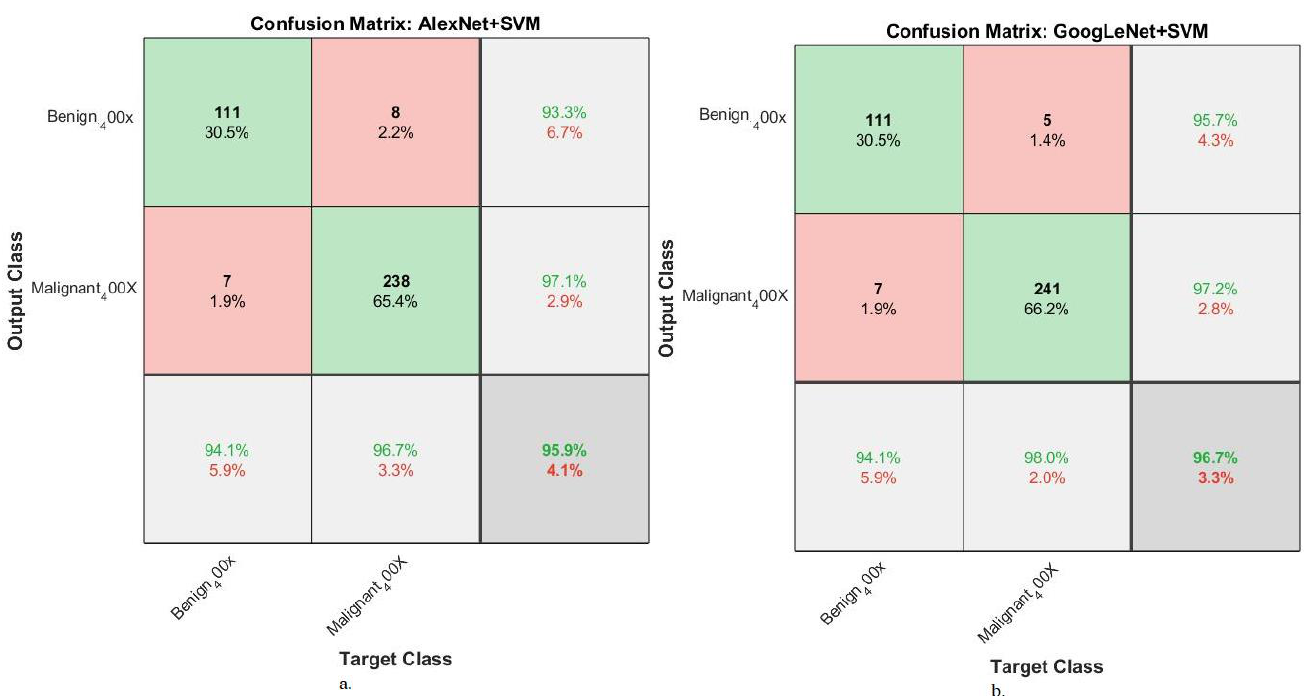
Figure 9. Evaluation of a BC dataset with a magnification of 400× by the confusion matrix produced by ( a ) AlexNet + SVM and ( b ) GoogLeNet + SVM.